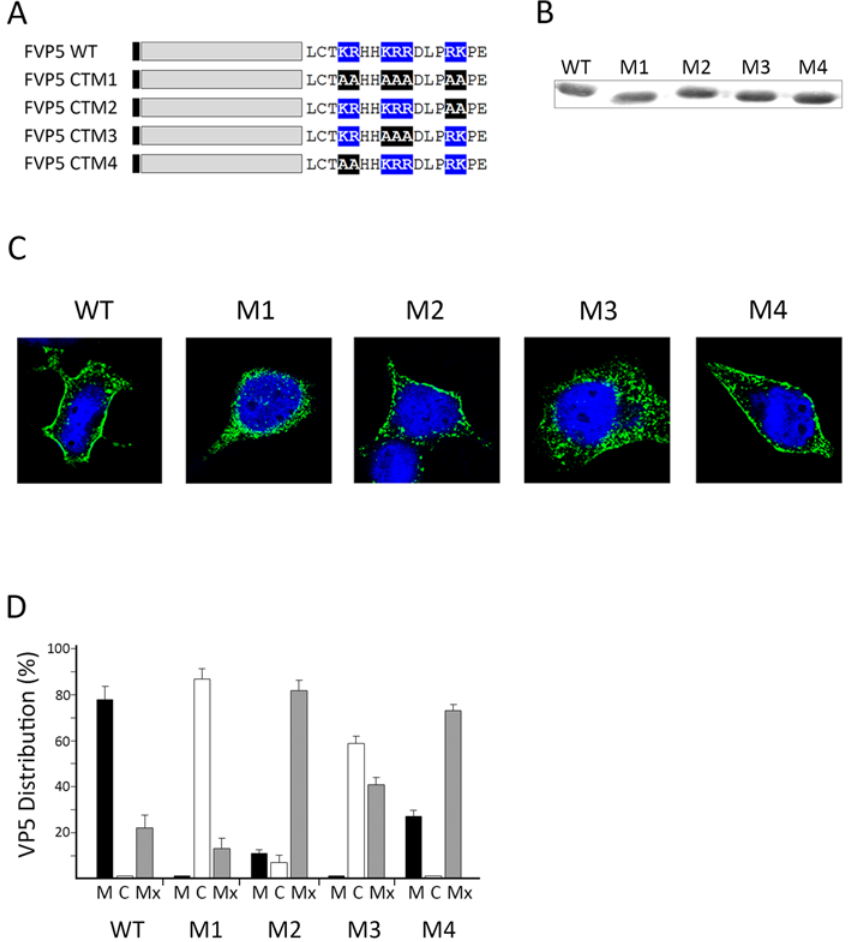
Fig 4. Contribution of the electropositive C-terminal charge to VP5 PM targeting. A. VP5 alanine replacement mutants. Diagram depicting Flag-tagged VP5 proteins expressed by the different recombinant VACVs used in this analysis. The M1 protein lacks the three cationic clusters whilst M2, M3, and M4 lack the 132 KR 133 , the 136 KRR 138 or the 142 RK 143 clusters, respectively. A Flag-tagged version of the wild type protein (WT) was used as control. The black box indicates the position of the Flag tag. Positively charged amino acids at the VP5 C-terminus are highlighted in blue, and the replacing alanine residues in black. B. Protein expression analysis. Samples from cells infected with recombinant VACV expressing the different proteins were subjected to SDS-PAGE and Western blot analysis using anti-Flag mAbs. Subcellular VP5 distribution. C. Single cell images. Coverslips containing cells infected with the different recombinant VACVs were processed for IF using a mouse anti-Flag mAb followed by incubation with goat anti-mouse coupled to Alexa- 488 (Green). Nuclei were stained with DAPI (Blue). Cells were visualized by CLSM. Fluorescence signals were recorded separately by using appropriate filters. Images correspond to confocal sections showing the overlay of the two fluorescence signals, and are characteristic examples of the GFP-specific immunofluorescence observed in cells infected with the different recombinant VACVs. D. Statistical analysis. Cells showing more than 70% of the total Flag-specific signal at the plasma membrane or the cell cytoplasm were scored as having a predominant plasma membrane (P) or cytoplasmic (C) distribution. The remaining cell fraction was considered as exhibiting a mixed (Mx) plasma membrane/cytoplasmic distribution. Analyses were performed with data collected from three independent experiments using a total of over three hundred single cell